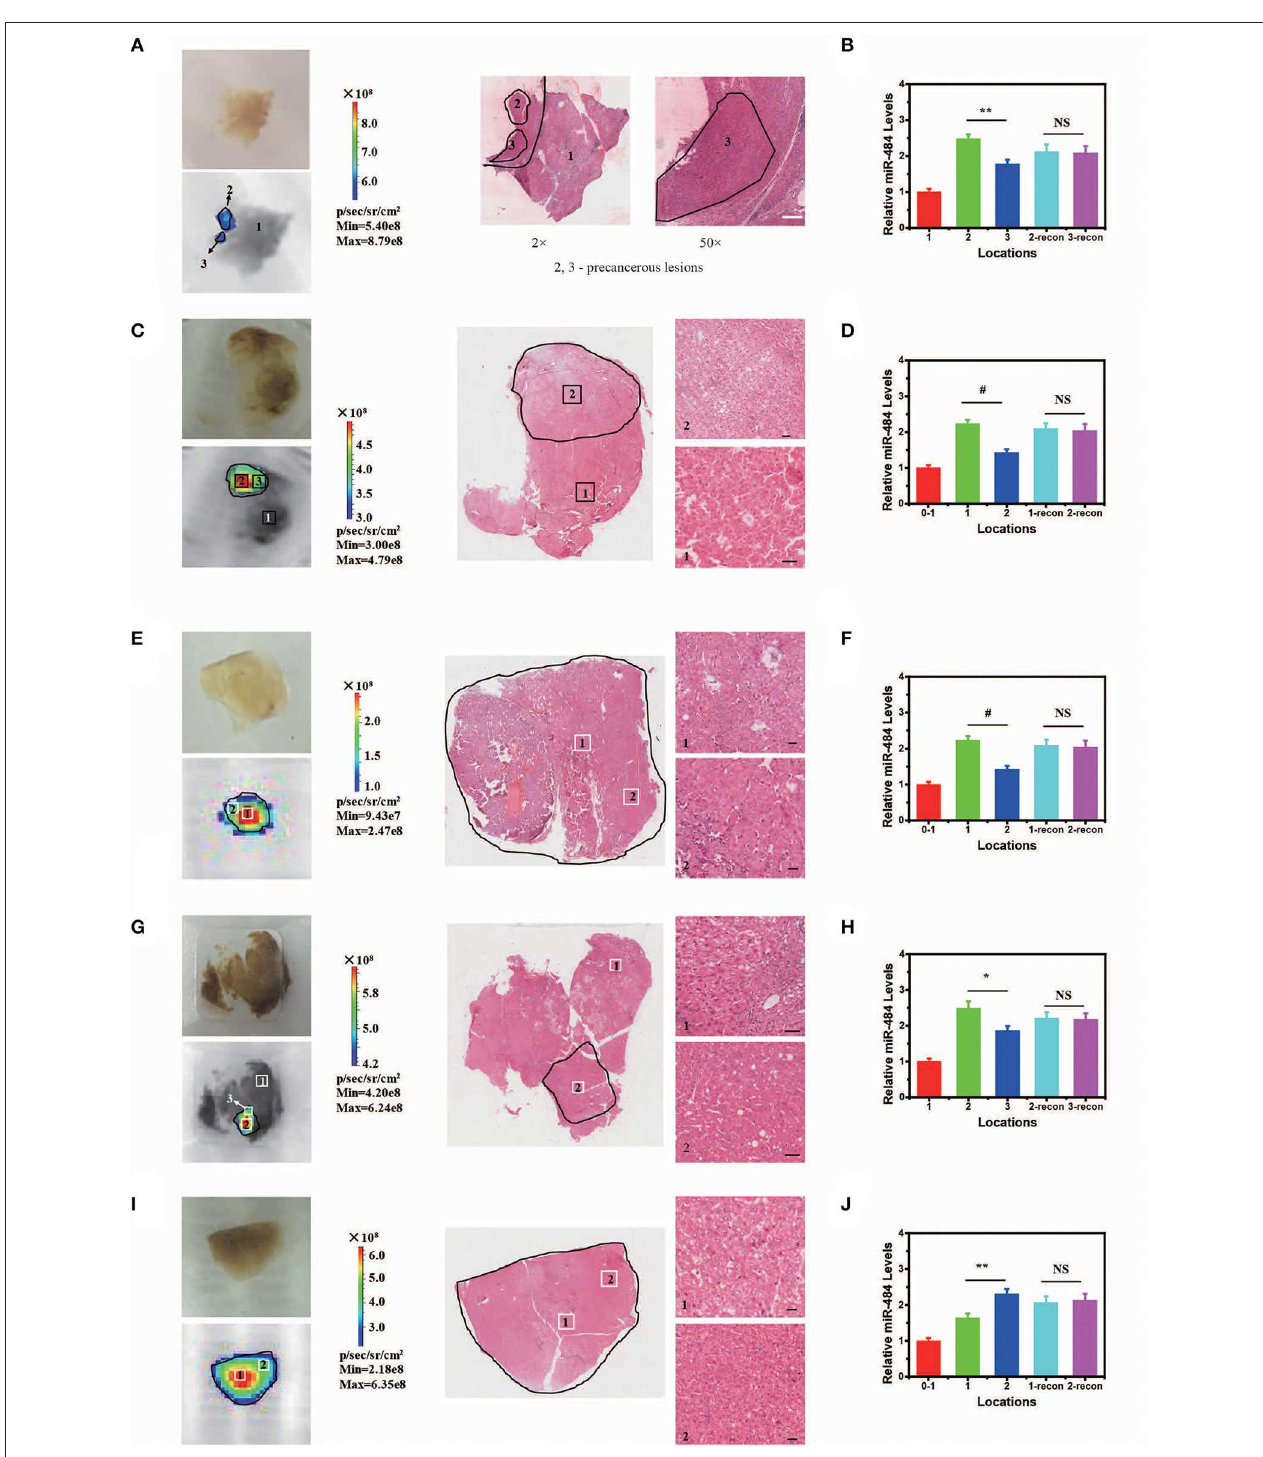
FIGURE 5 | Visualization and three-dimensional (3D) reconstruction of miRNA in vivo Based on Human Liver Samples. (A,C,E,G,I) (from left to right) Bright field image and fluorescence image of human liver samples 1–5. Microscopic image of human liver samples 1–5. In (A,C,G) , normal tissue and precancerous lesions are marked 1, 2, and 3. Scale bars, 90 µ m. In (E,I) , precancerous lesions are marked 1 and 2 according to the difference in fluorescence intensity. Scale bars, 60 µ m. (B,D,F,H,J) Relative miR-484 levels at different locations in human liver samples 1–5 (ANOVA and the t -test were used to analyze the means, # p < 0.001; * p < 0.05; ** p < 0.01; NS, no significant